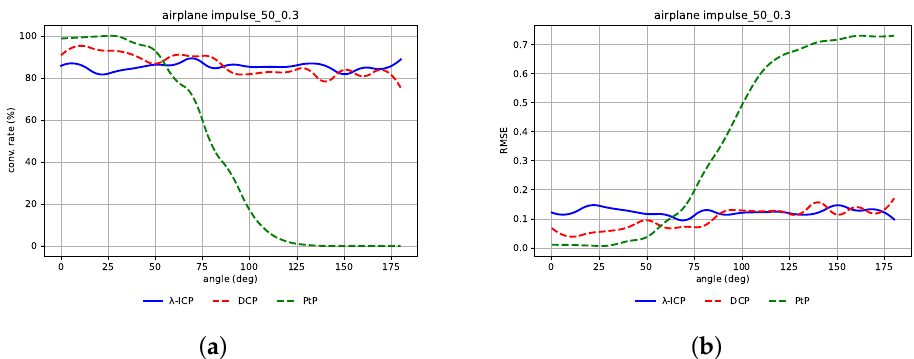
Figure 20. ( a ) Convergence rate of λ -ICP (blue), DCP (red), PtP (green) algorithms for airplane with impulse noise; ( b ) mean RMSE (for transformation matrices) of λ -ICP (blue), DCP (red), PtP (green) algorithms for airplane with impulse noise.